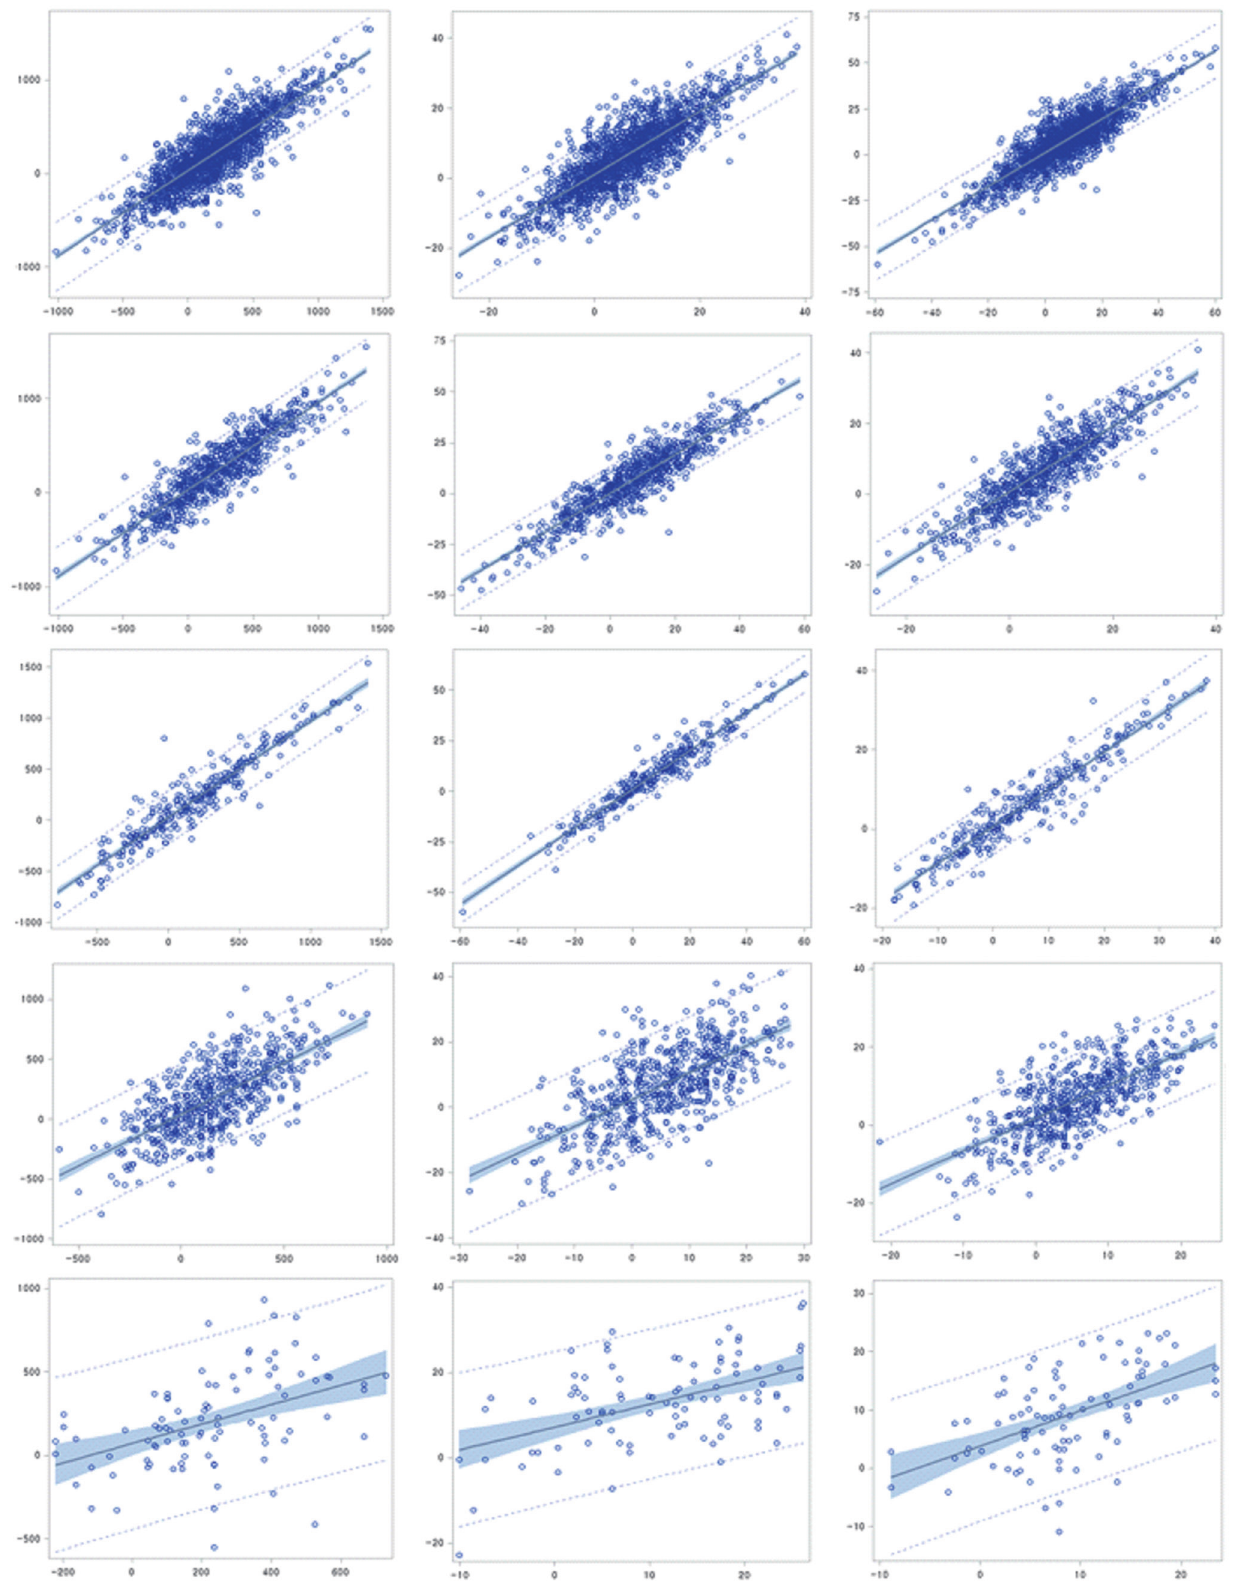
Figure 1. Relationship between breeding value (EBV) and genomic breeding value (GEBV) for milk, fat protein yields (left; milk, center; fat, right; protein) in each group (from top to bottom; overall, cows with record, sires with progeny, heifers without record and bulls without